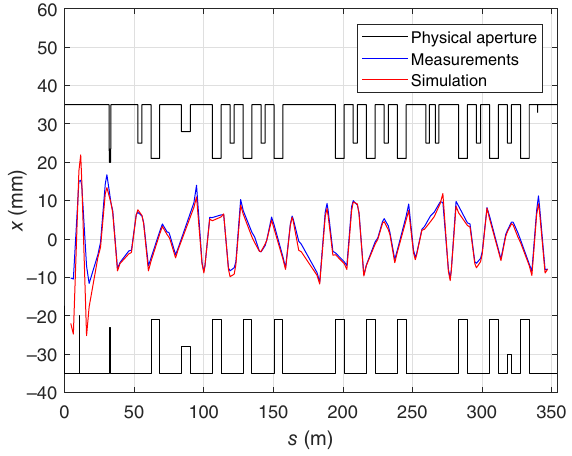
FIG. 18. Measured (blue) and simulated (red) horizontal first turn orbit. The horizontal physical aperture is plotted in black solid lines.